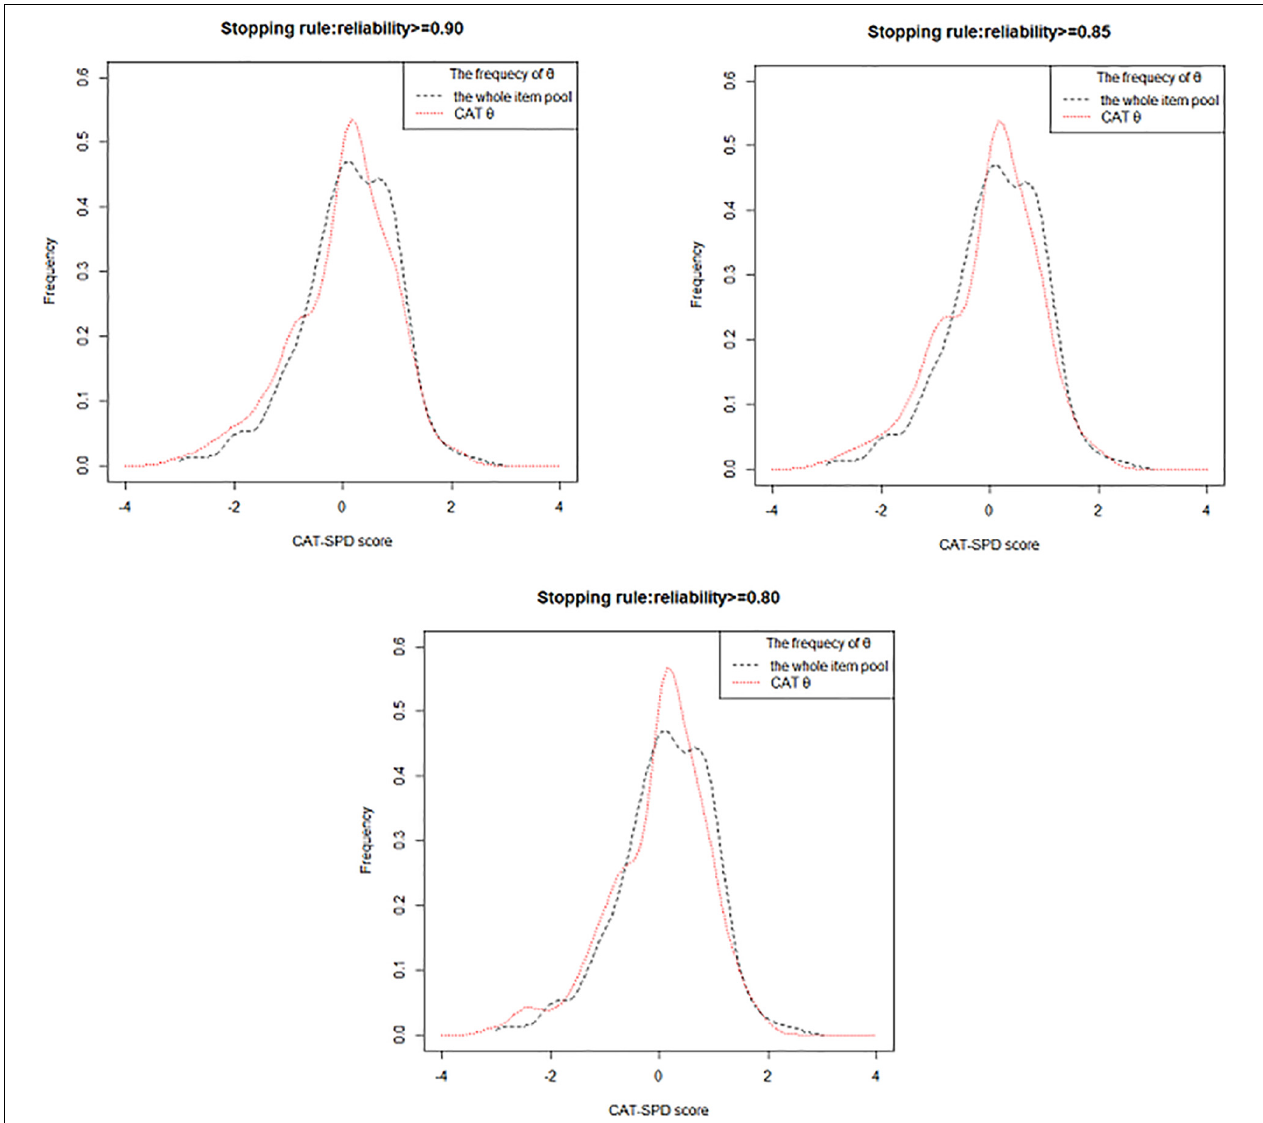
FIGURE 1 | Frequency distribution of the whole item pool and CAT-SPD score under different stopping